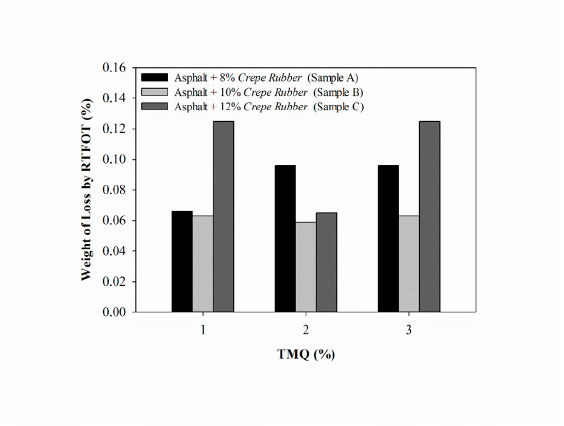
Figure 3. Weight of loss by RTFOT.